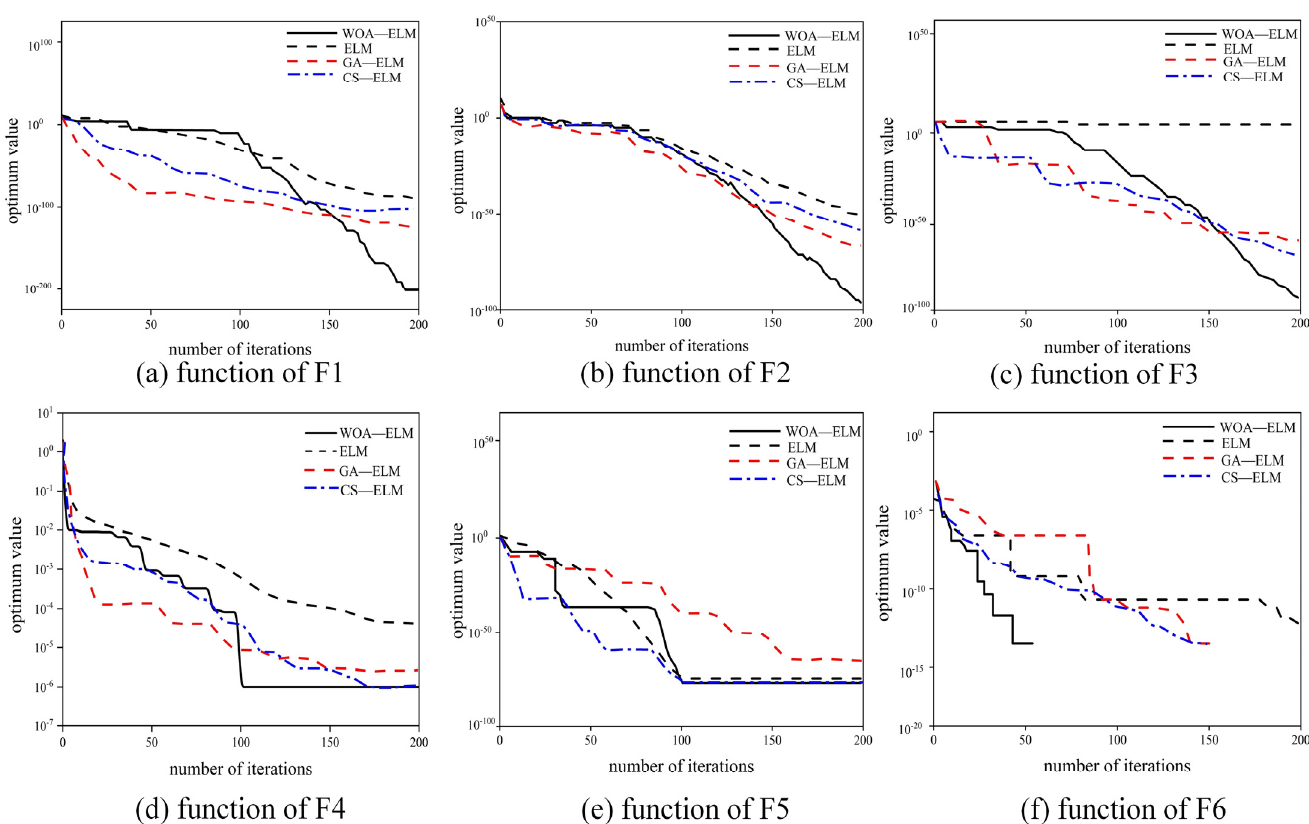
Figure 6. Convergence plots under each benchmark function.